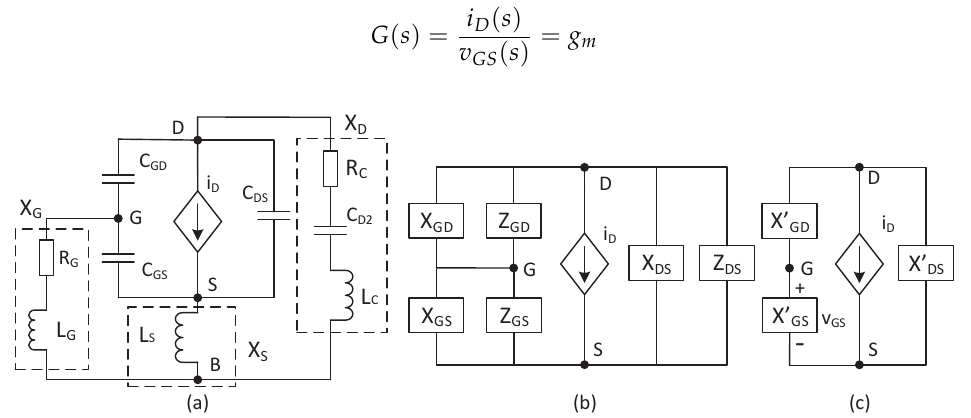
Figure 9. An equivalent ac model of the test circuit. ( a ) An equivalent small-signal circuit. ( b ) The initial small-signal model. ( c ) A simplified small-signal model.